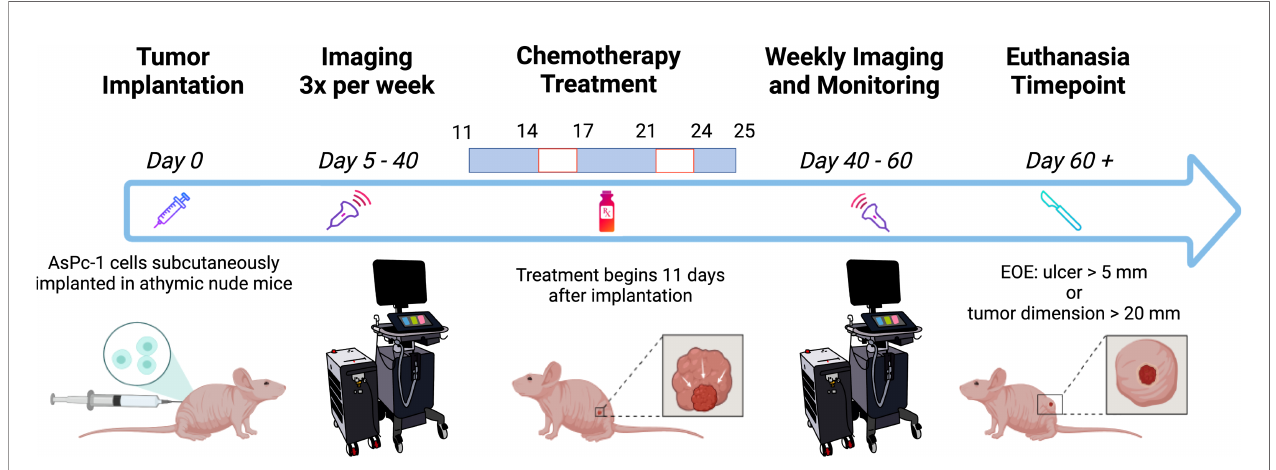
FIGURE 1 | Schematic of the experiment timeline. The mice were imaged frequently before and during chemotherapy treatment. Weekly imaging ensued 40 days after tumor implantation through the end of the experiment (EOE). Created with